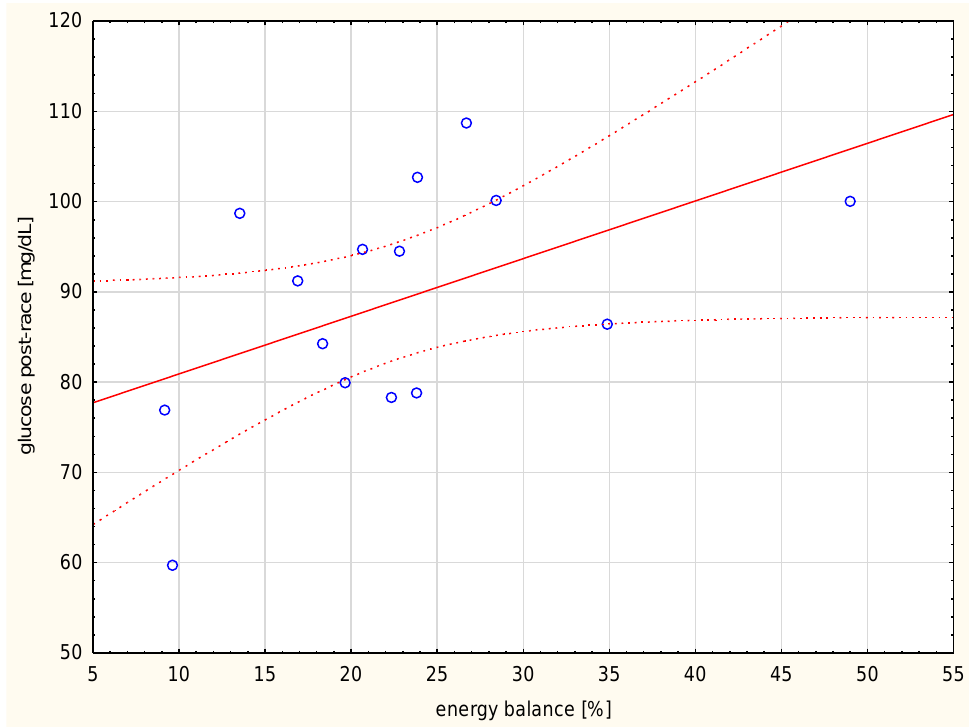
Figure 1. Correlation between energy balance (%) and glucose level after the run ( r = 0.589, p < 0.05). Table 3. Biochemical parameters in the serum of participants at baseline and post-race. Parameter Pre-Race Post-Race